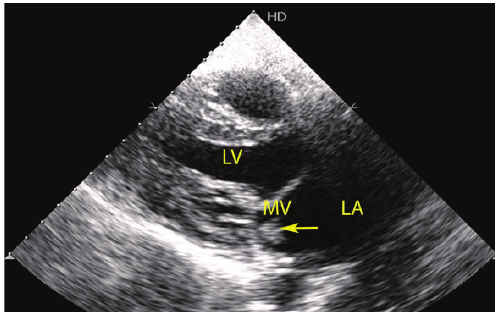
Figure 1: Two-dimensional transthoracic echocardiography in parasternal long axis view illustrating the vegetation (arrow head). In addition, significant submitral pathology can be appreciated. (LA: left atrium, MV: mitral valve, LV: left ventricle).